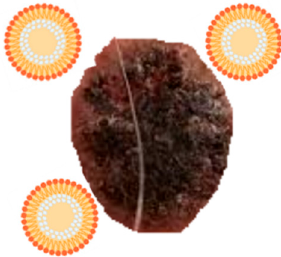
Figure 6. Solid lipid nanoparticles’ (SLNs’) interaction with